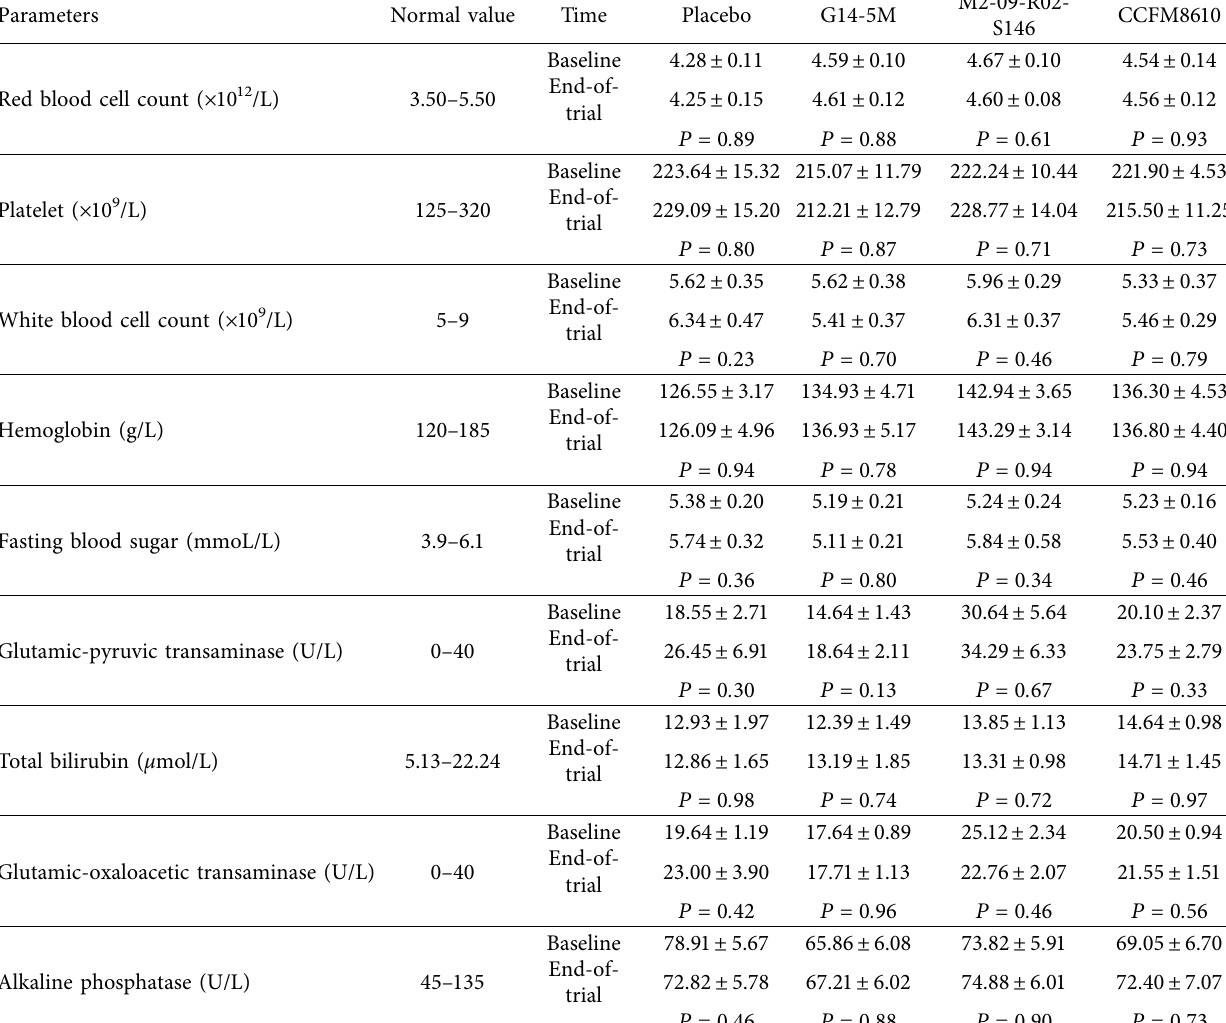
Table 2: General physiological characteristics of patients.